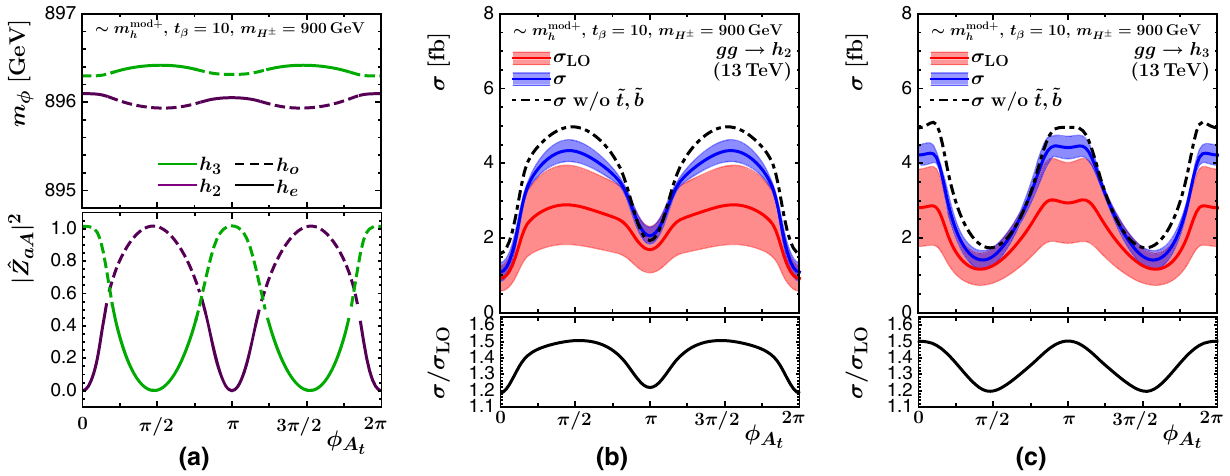
Fig. 6 a Masses of h 2 and h 3 in GeV as well as CP -odd charac- tion ( blue ) for b h 2 and c h 3 in fb as a function of φ A ter |ˆ Z aA | 2 as a function of φ A scenario. The black , dot-dashed curve depicts the best prediction for in the m mod + -inspired scenario with h t tan β = 10. The solid and dashed curves depict regions in φ A where the cross section without squark contributions (except through ˆ Z fac- t h 2 and h 3 are predominantly CP -even ( h e ) or odd ( h o ), respectively, tors). In the lower panel we show the K -factor σ/σ LO . The depicted uncertainties are scale corresponding to |ˆ Z aA | 2 beingbeloworabove0 . 5asshowninthe lower panel . b , c LO ( red ) and best prediction for the gluon-fusion cross sec-